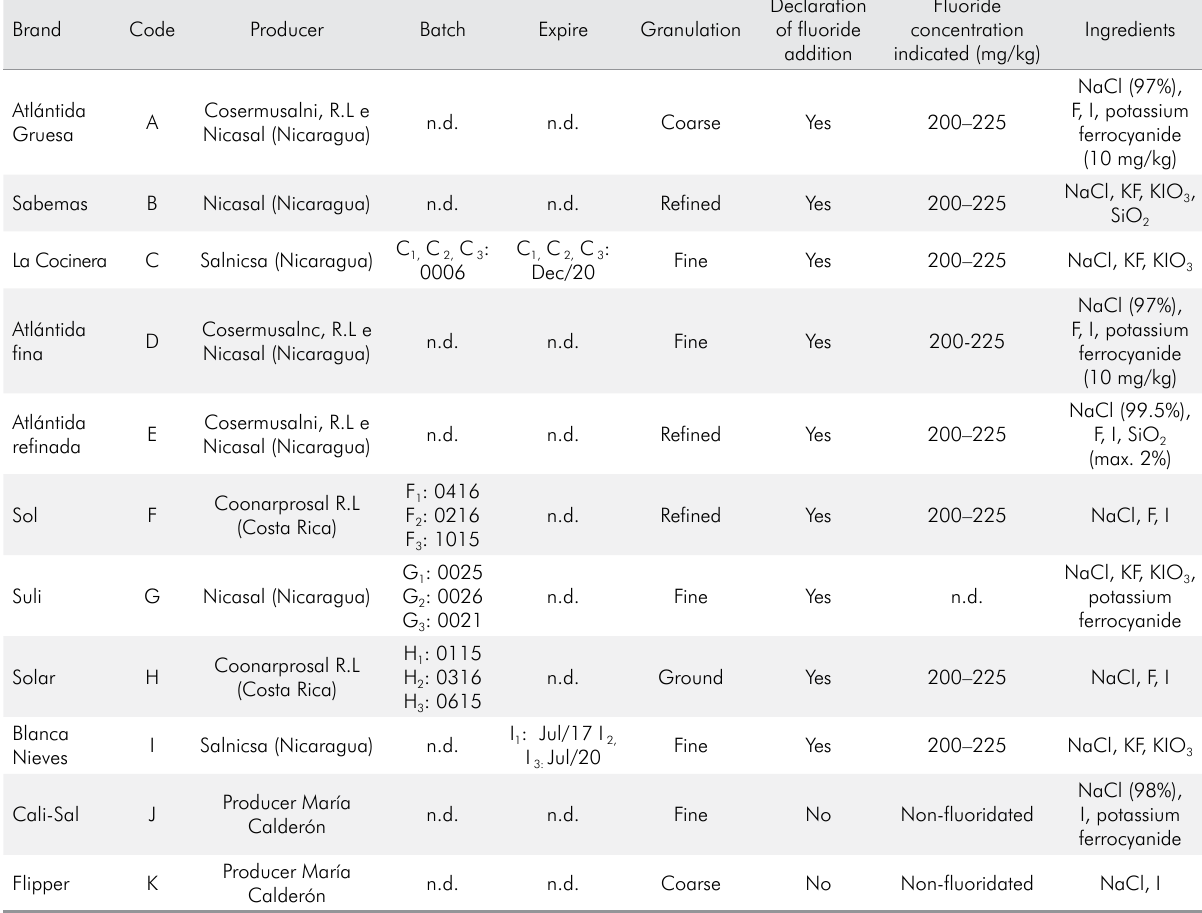
Table 2. Salt brand characteristics, according to label